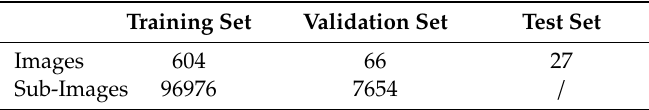
Table 1. Detailed distribution of the dataset used in this